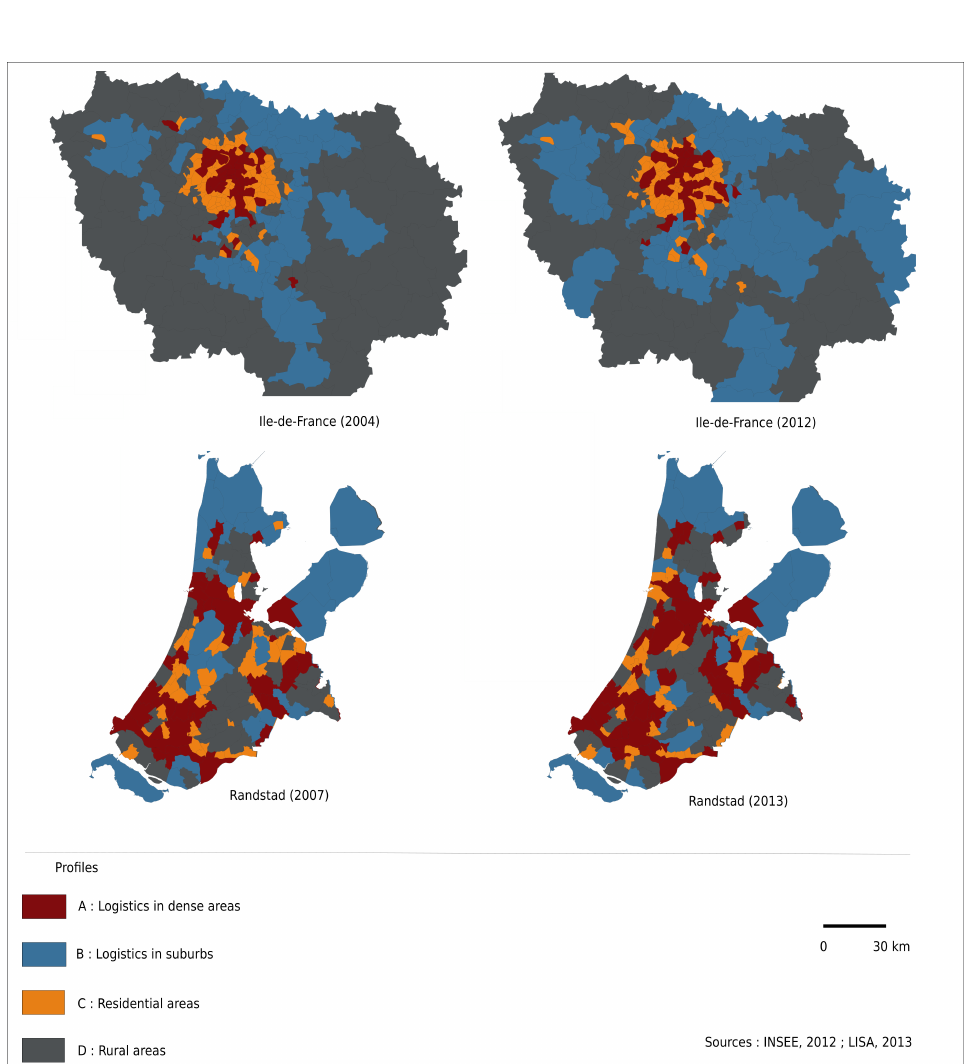
Figure 1: Comparison between local profiles in the Paris and Randstad regions